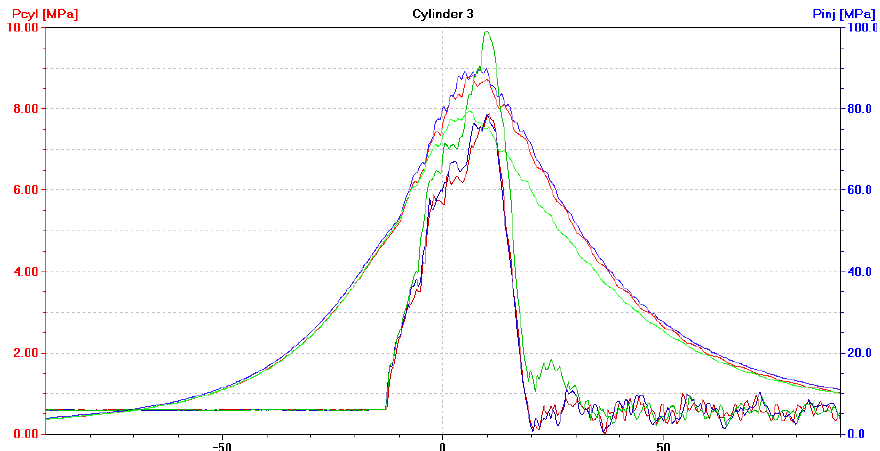
Figure 11. The diagram (screenshot of Unitest 2008) illustrates p cyl = f( α ) with the fuel injection characteristics of p inj = f( α ) for DEU with a defective ship engine-coked injector nozzle in the third cylinder, loaded at 70% MCR. Waveforms for cylinder: — No. 1, — No. 2, — No. 3.